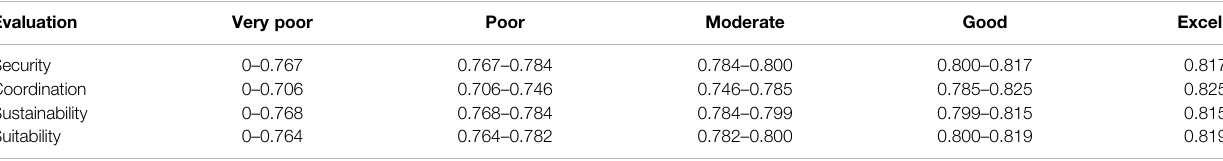
TABLE 5 | The indicator value range corresponding to the evaluation standard.